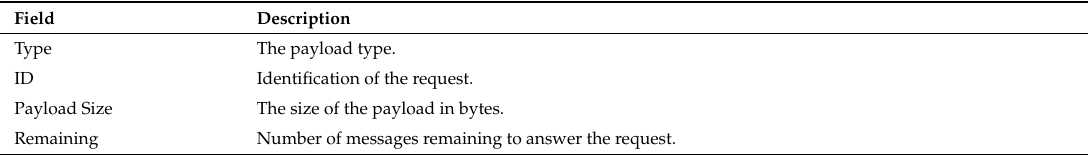
Figure 4. QualiCare message types and its contents. All messages use the same network header, which identifies the packets. Table 2. Description of the network header